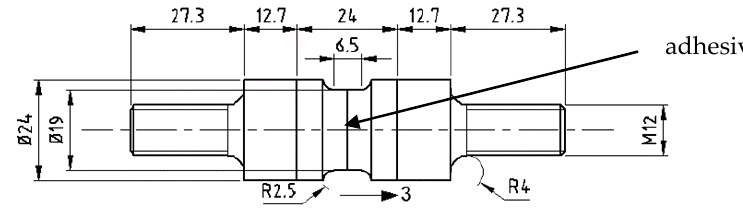
Figure 2. TRAZ-BJ specimen. Dimensions are in mm.